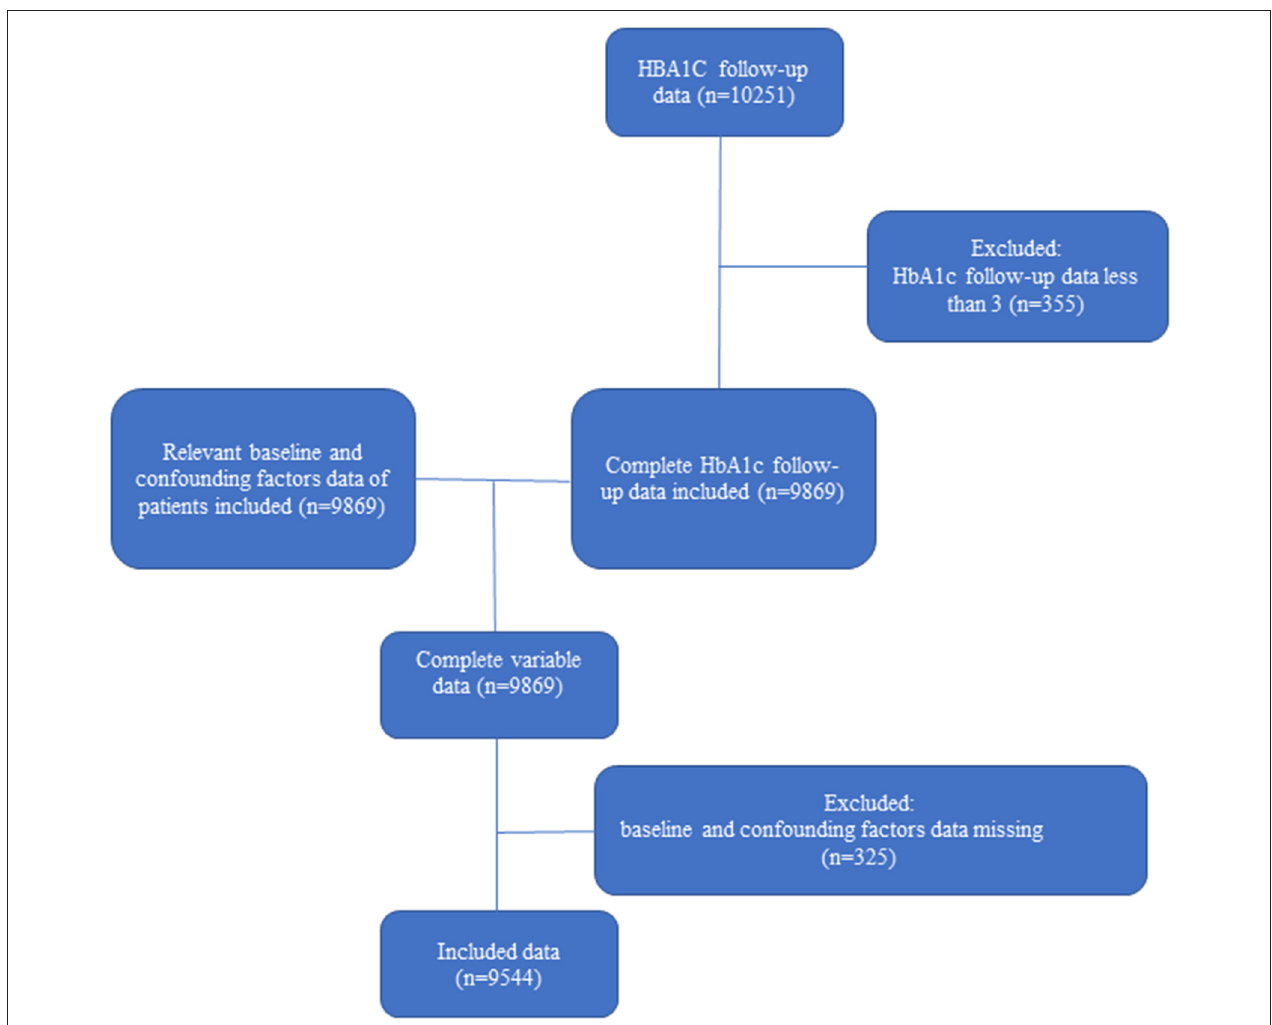
FIGURE 1 | Flow chart of this